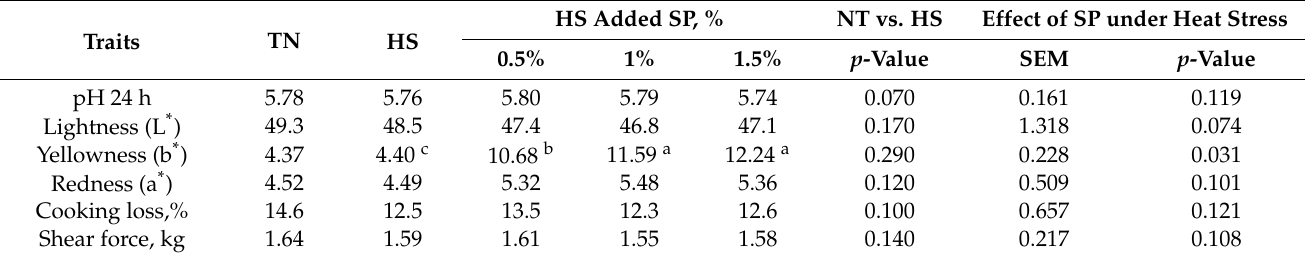
Table 7. Effect of dietary Spirulina platensis supplementation at different levels on meat quality of broiler chickens subjected to cyclic heat stress starting from 22 to 42 days of